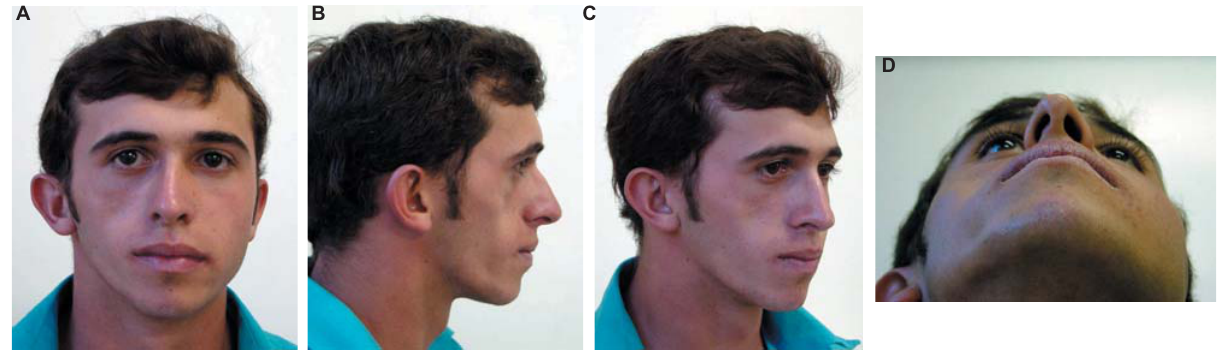
Figure 1A-D- Facial depression compromised the facial esthetics (patient signed informed consent authorizing the publication of these pictures)